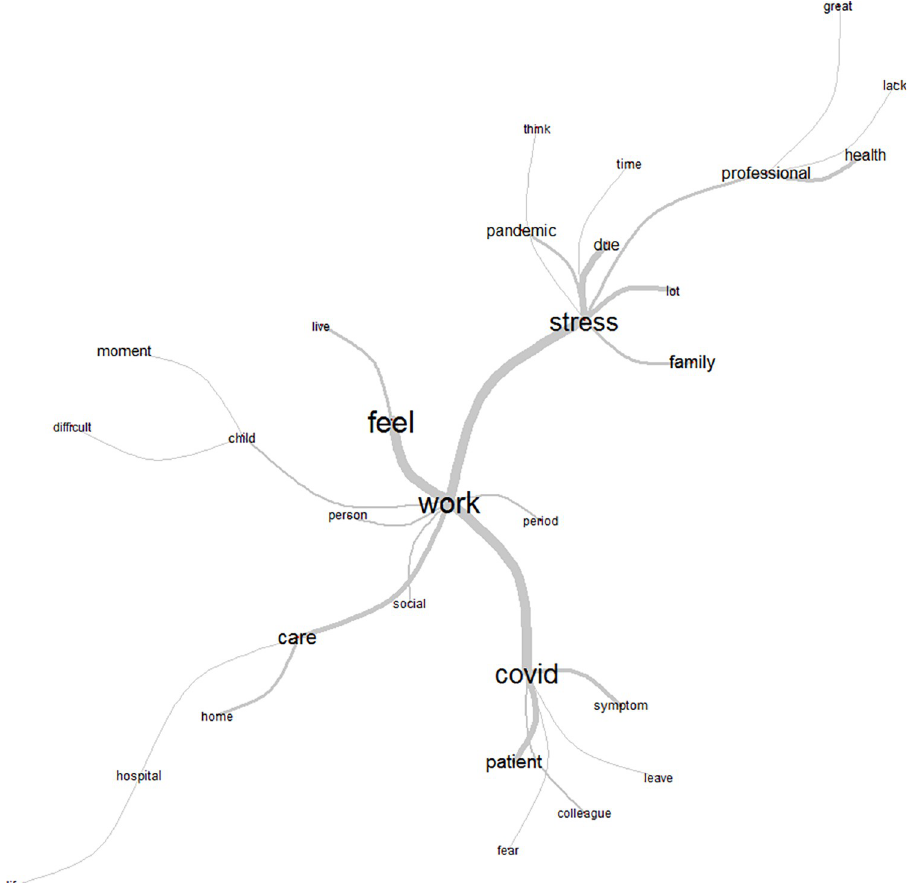
Fig 4. Similarity tree for Class 2: work/labor issues. Source: COVIDPRO Project (2020). Rio de Janeiro–Brazil, 2020. (N =